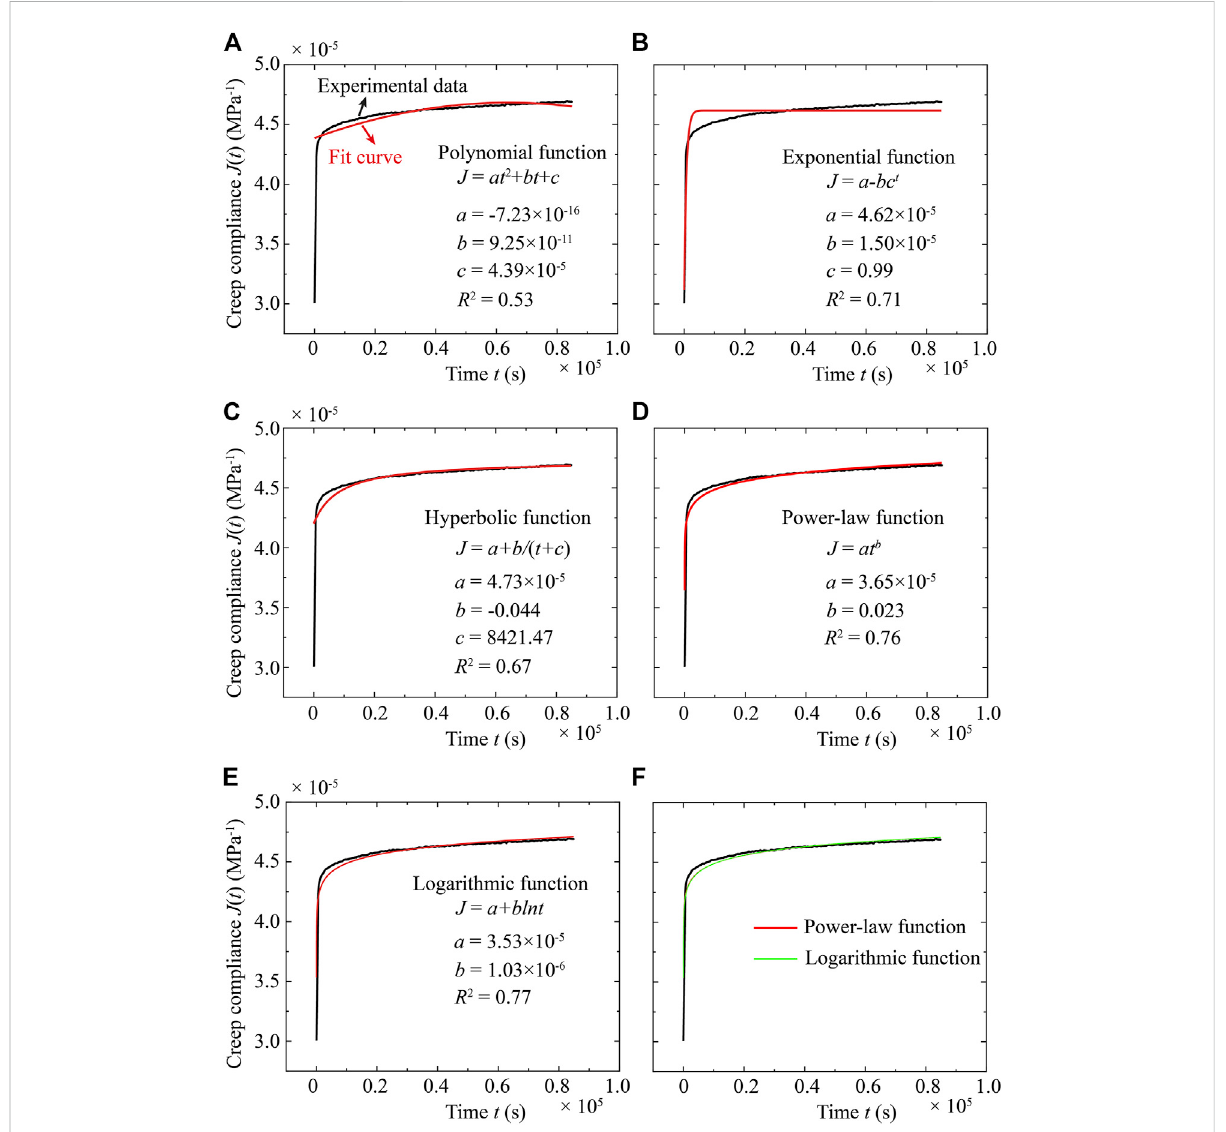
FIGURE B1 Comparison of different functions fi t to the creep experimental data: (A) Polynomial function with three parameters; (B) Exponential function with three parameters; (C) Hyperbolic function with three parameters; (D) Power-law function with two parameters; (E) Logarithmic function with two parameters; (F) Comparison between the power-law and logarithmic functions. The experimental data are from the differential stress (60 MPa) stage of Sample